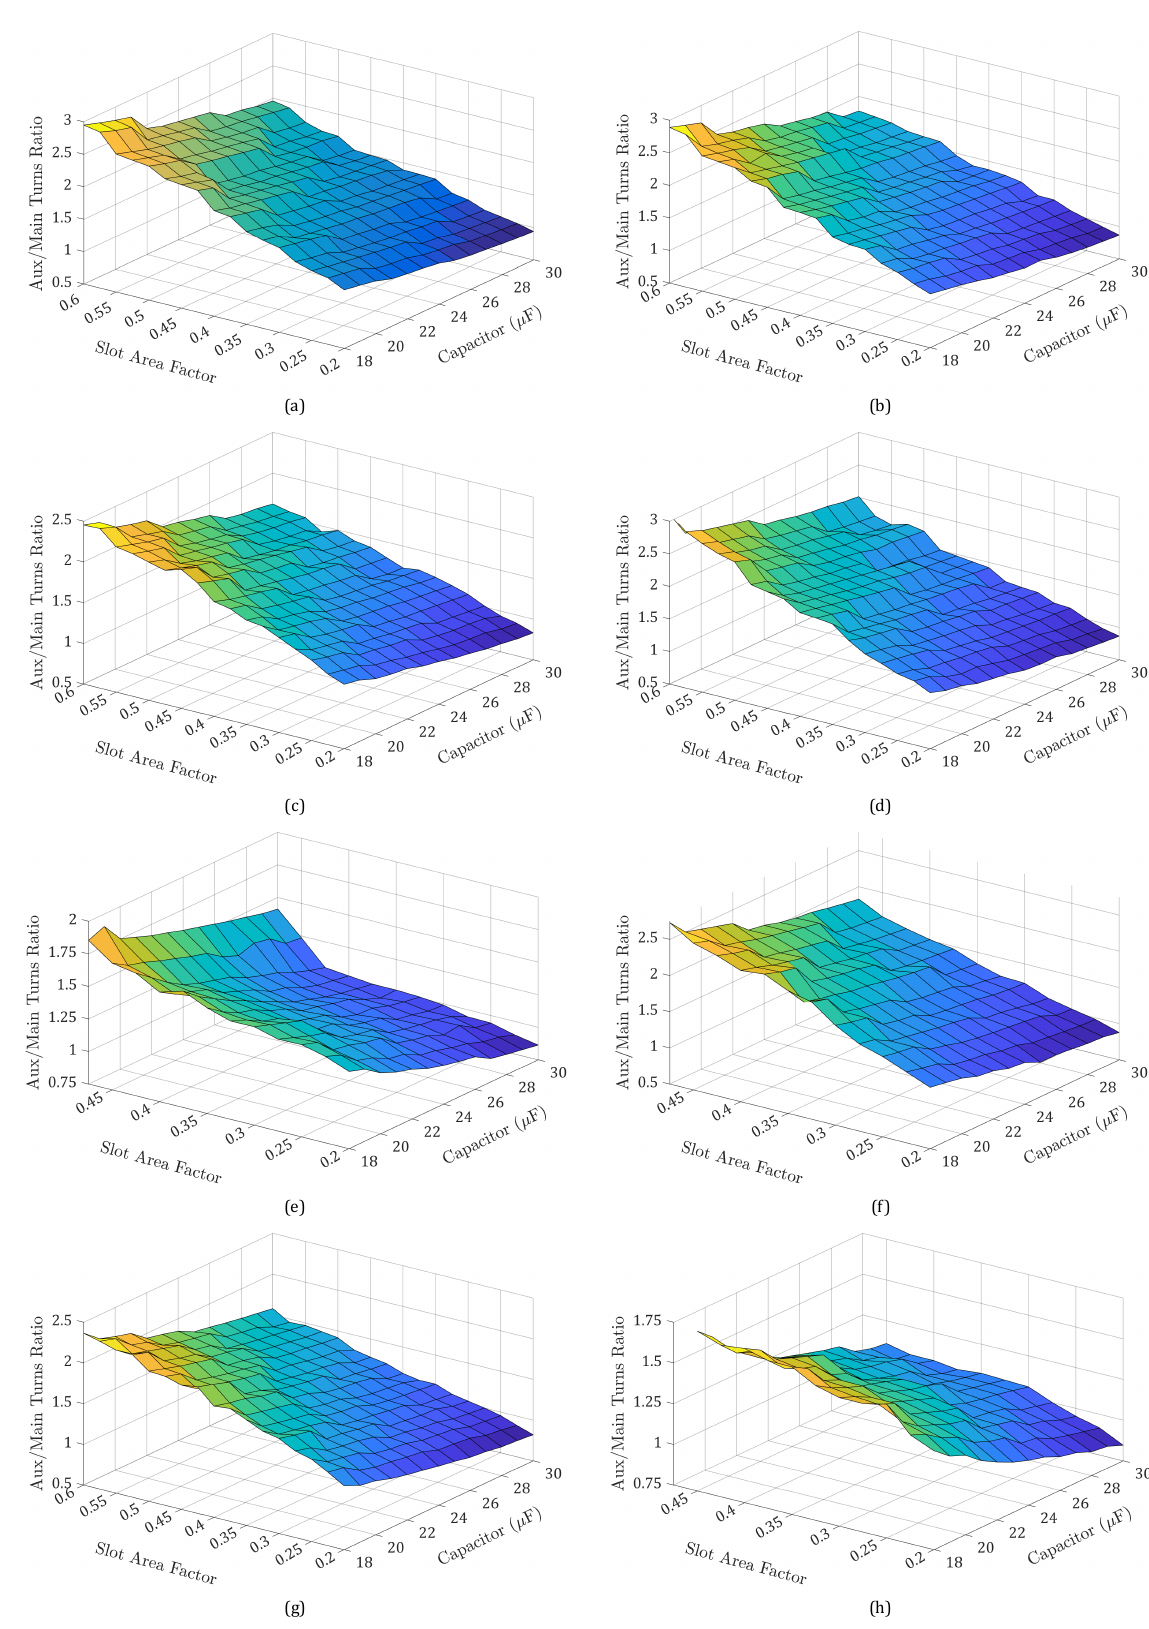
Figure 6. Impact of C run and k bar on auxiliary to main winding turns ratio of SPIMs with rotor squirrel- cage bars of: ( a ) trapezoidal, ( b ) oval, ( c ) pent, ( d ) polygonical, ( e ) round, ( f ) drop, ( g ) rectangular, and ( h ) quadrangular